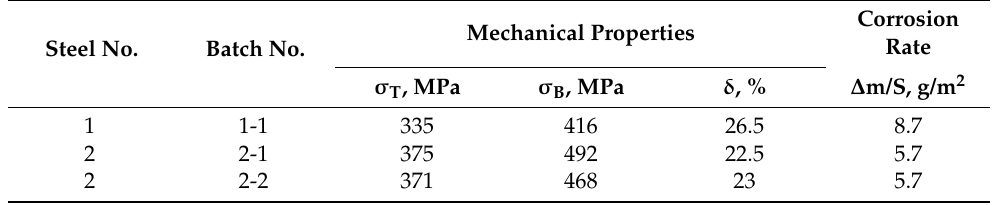
Table 3. Results of mechanical and corrosion tests. Steel No. Batch No.